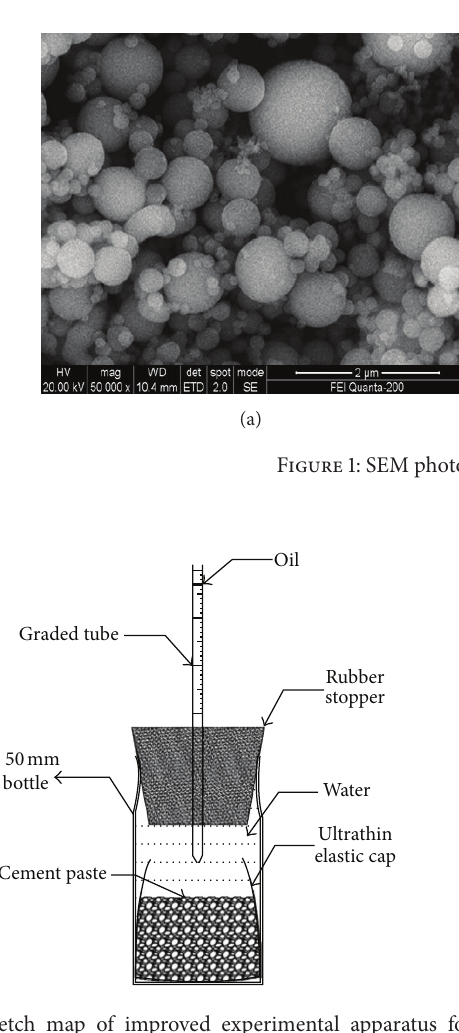
Figure 2: Sketch map of improved experimental apparatus for ASTM C1608 1#, A2, B2, and C1 samples at the age of 3 d.